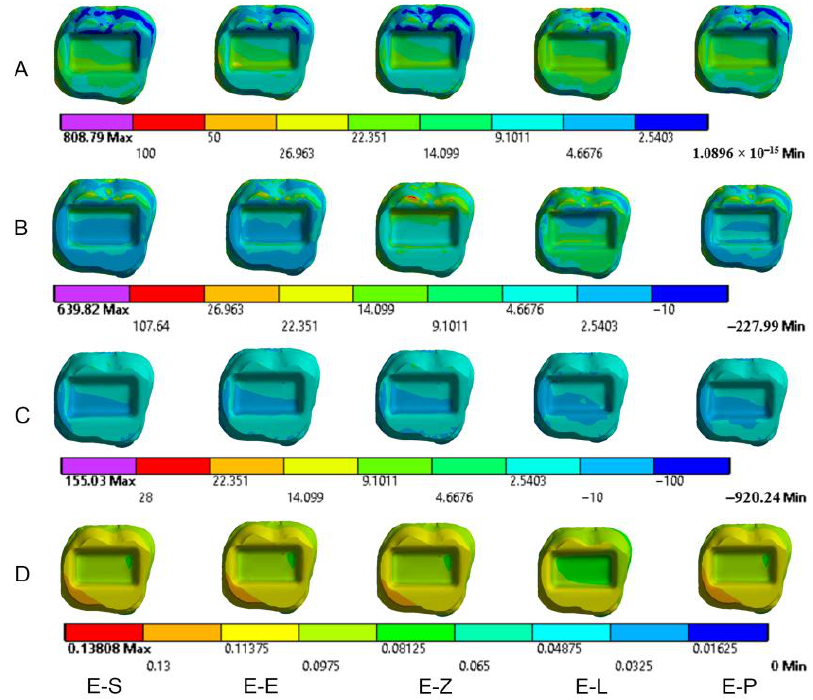
Figure 11. Stress distribution and displacement of dentin in all models under oblique loading. ( A ) von Mises stress, ( B ) maximum principal stress, ( C ) minimum principal stress and ( D ) displacement. E-S: zirconia-reinforced lithium silicate ceramic model, E-E: lithium disilicate glass ceramic model, E-Z: translucent zirconia model, E-L: resin nanoceramic model and E-P: polymer-infiltrated ceramic network model.